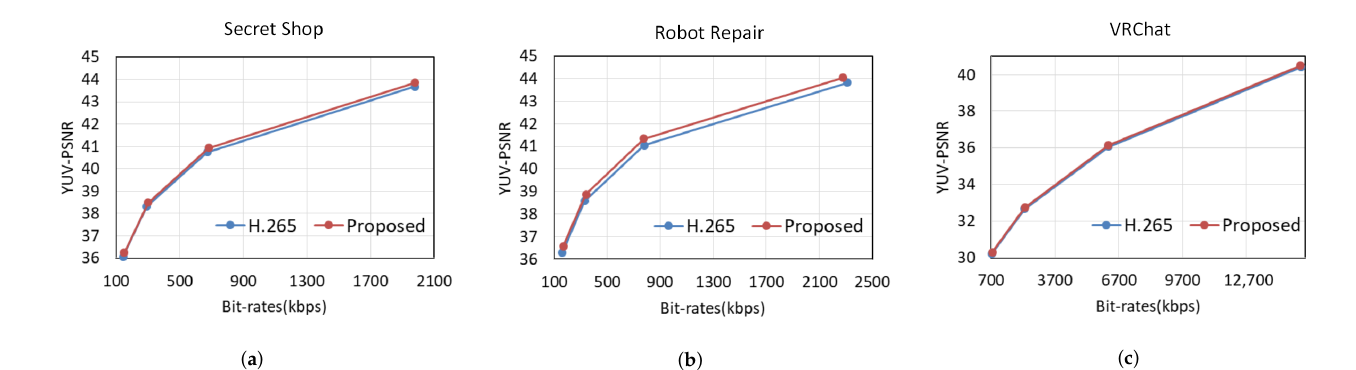
Figure 6. Rate-distortion curves of three test videos. ( a ) Secret Shop. ( b ) Robot Repair. ( c ) VRChat.